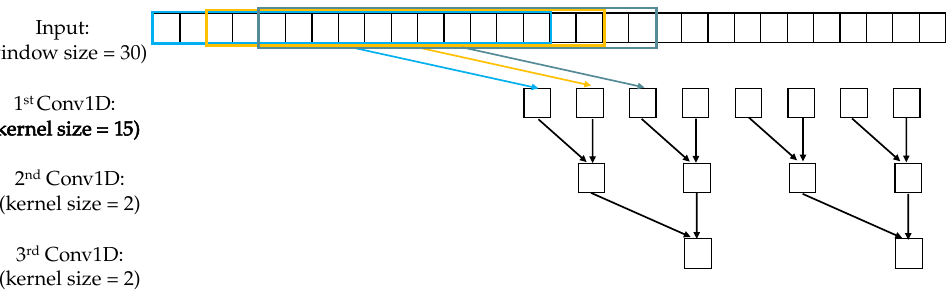
Figure 6. Long-scale module, window size = 30, strides = 2, kernel size = 15 (first layer), no zero